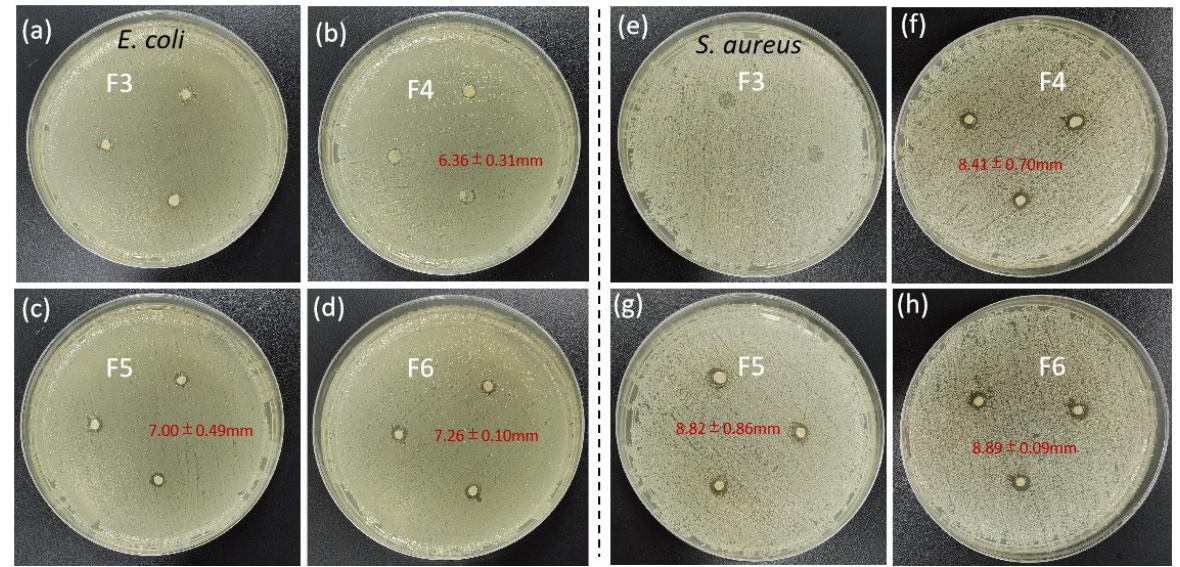
Figure 9. Inhibition zones of electrospun nanofiber membranes: ( a – d ) antibacterial effect of F3–F6 on E. coli ; ( e – h ) antibacterial effect of F3–F6 on S. aureus .